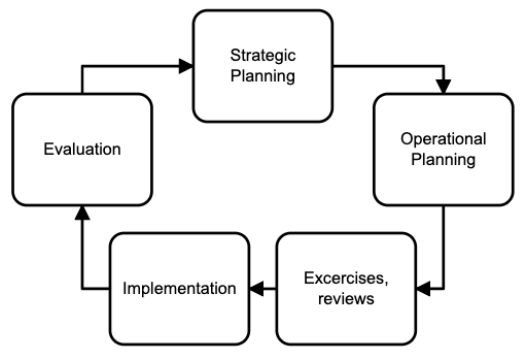
Figure 1. Key elements of pandemic